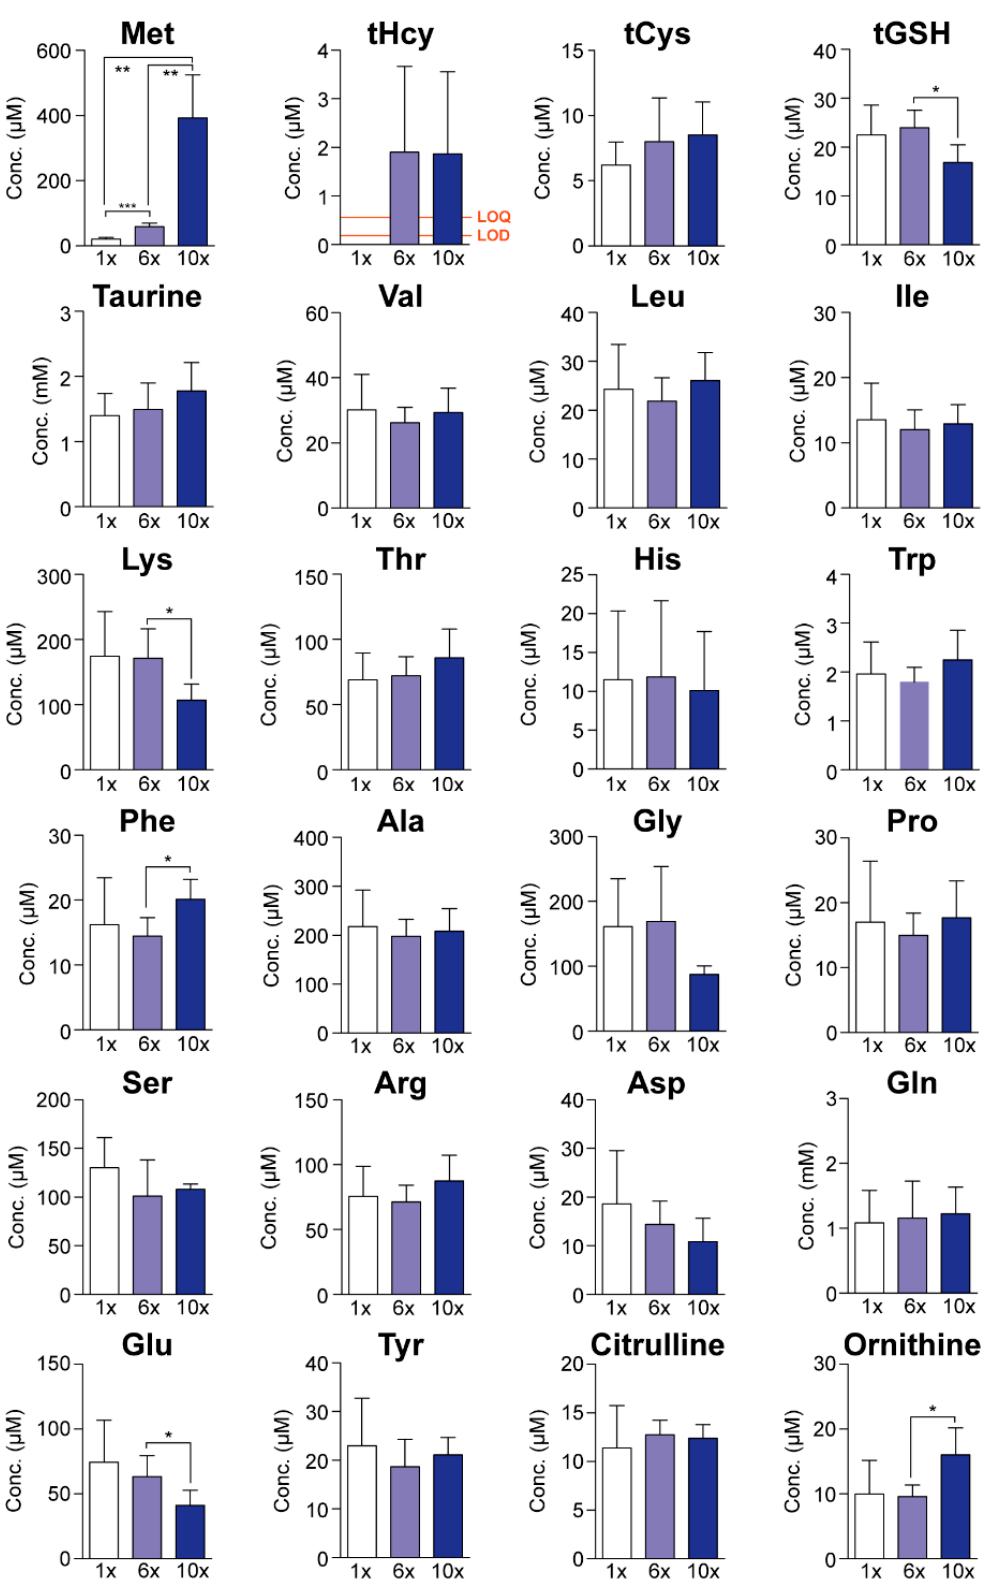
Figure 4. Impact of one-week high-methionine (Met) diet on cerebrospinal fluid (CSF) amino acid levels. Adult C57BL/6J male mice were ad libitum fed a standard CE-2 rodent diet (0.440% Met) until 8–9 weeks of age and then fed a standard (1 × Met), 6 × Met [2.64%], or 10 × Met [4.40%] diet for